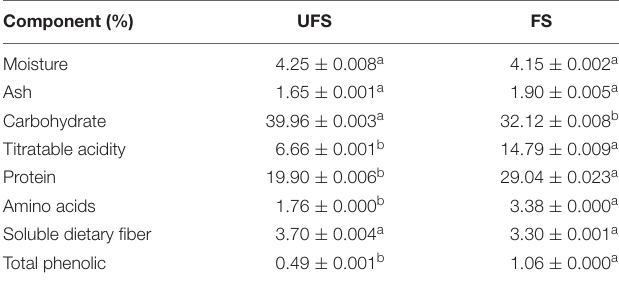
Data are represented as mean ± SD from three replicates. Values in the same row with different lowercase letters represent significant differences (p < 0.05) from each